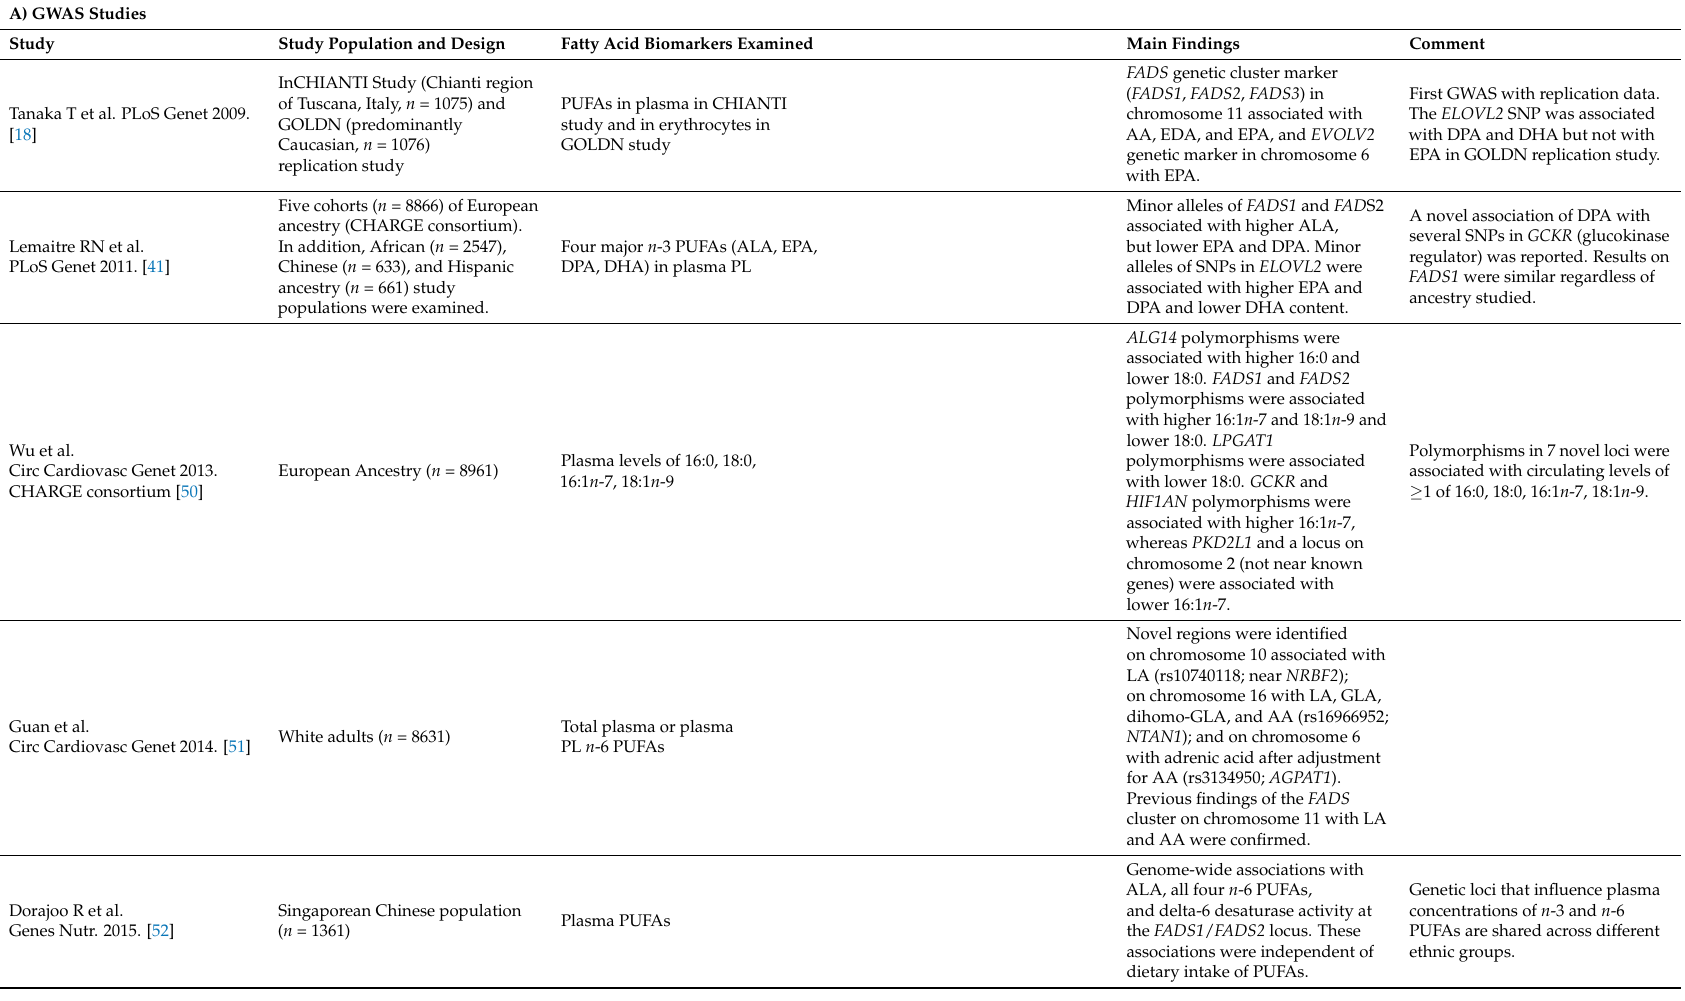
Table 2. Studies on the relation between genetic polymorphism and biomarkers of dietary fatty acids and reported interaction between diets and genetic variants regulating fatty acid metabolism. Part A includes genome-wide association studies (GWAS), Part B includes a priori selected genes, and Part C includes intervention